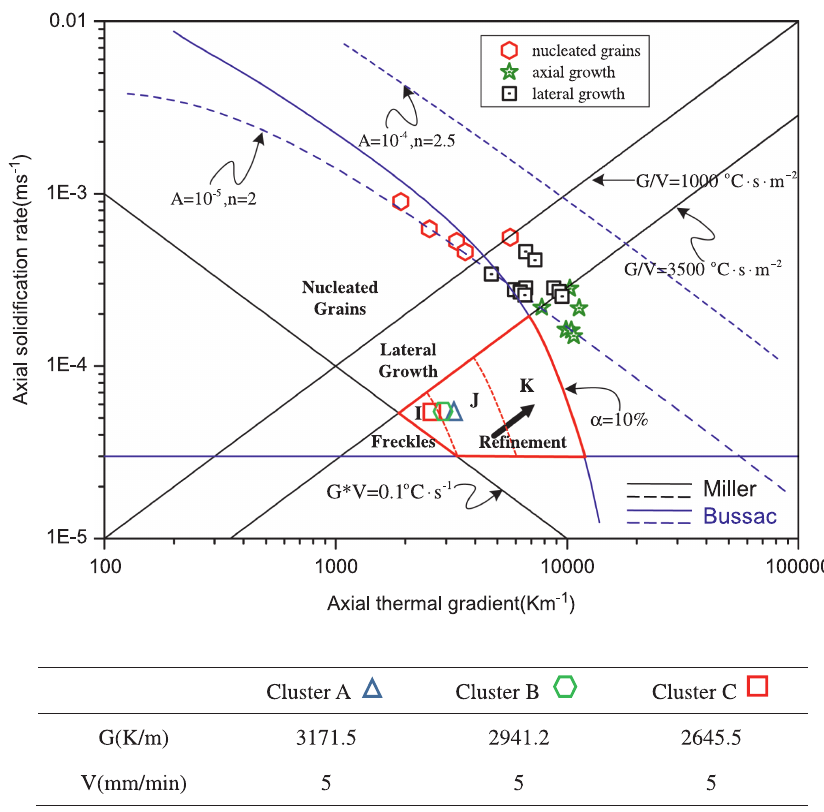
Figure 10: The modified process window in which SX area is divided into three more accurate parts – I, J and